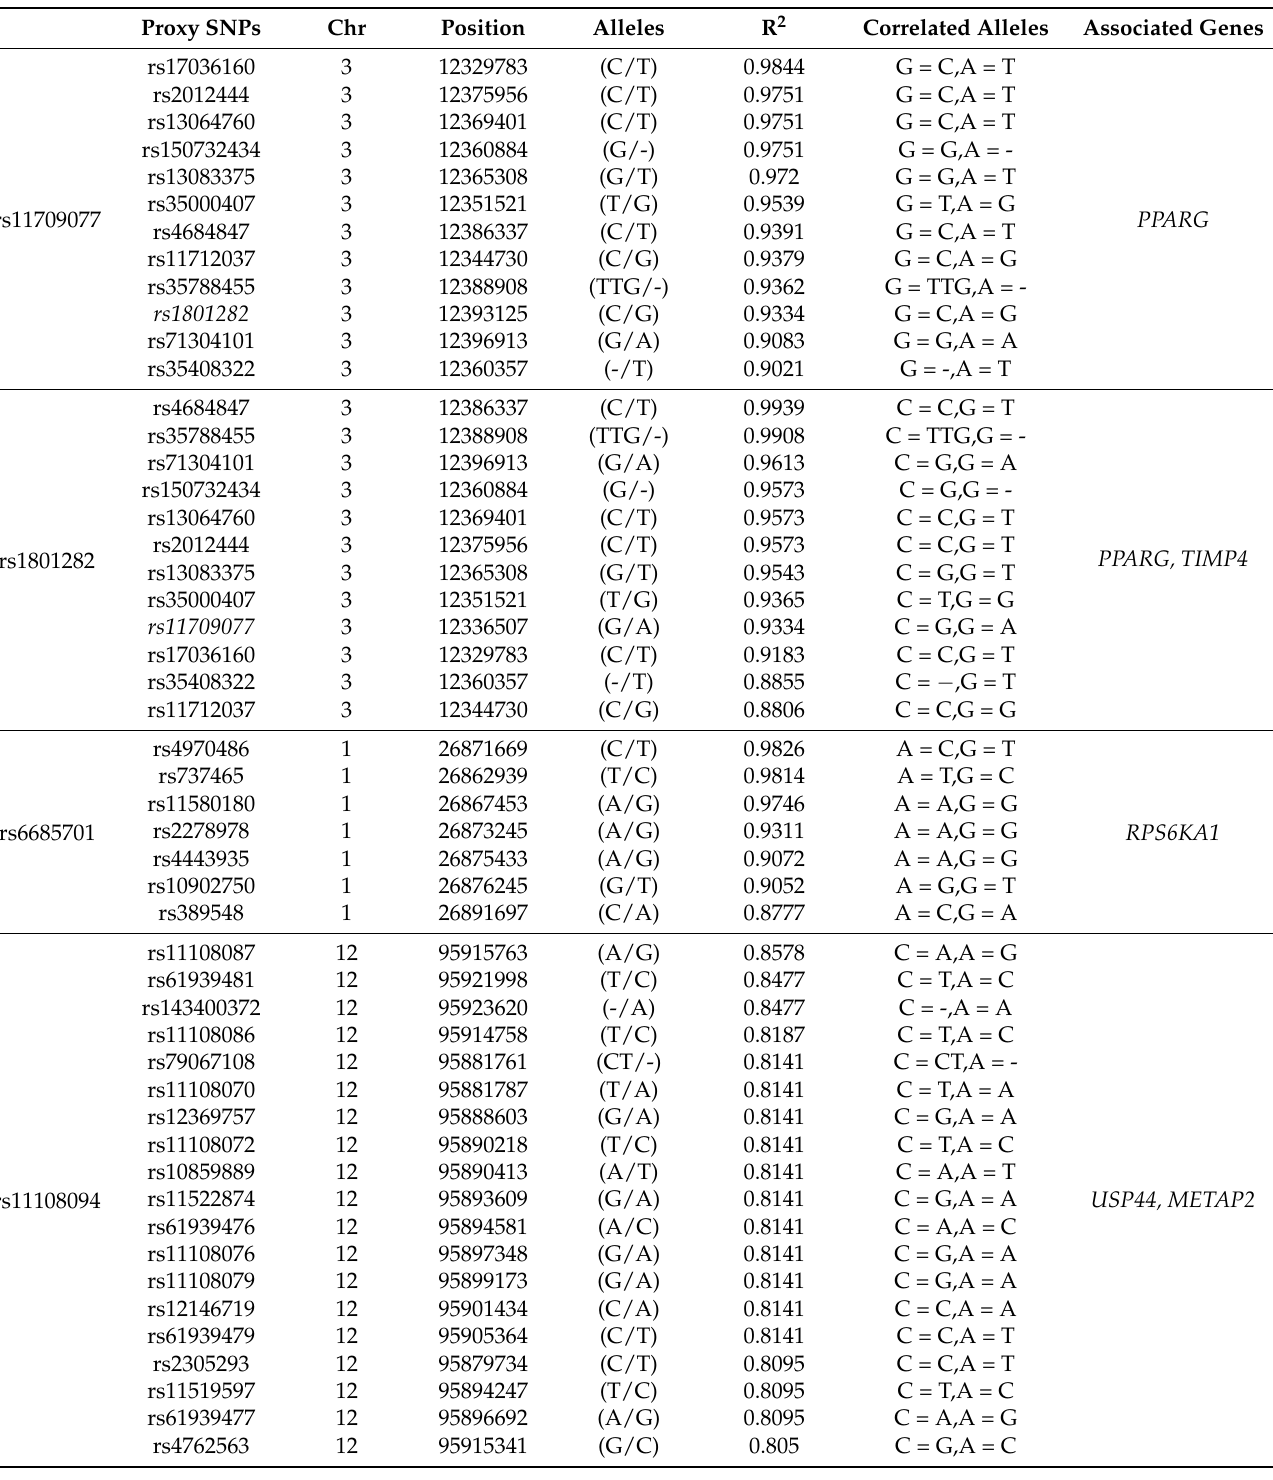
Table 3. Summary of the proxy SNPs (R 2 ≥ 0.8) for each common AML/T2D susceptibility SNP, along with their chromoso- mal location, correlated alleles and associated genes, as collected from LDLink tool [24] (May